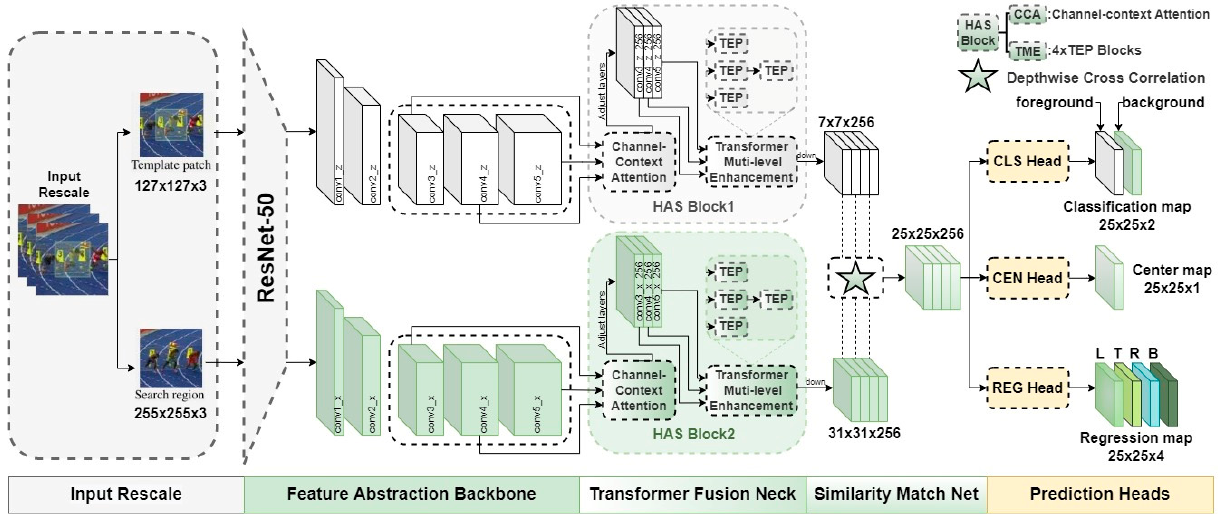
Figure 4. The overall framework of the proposed SiamHAS tracker.